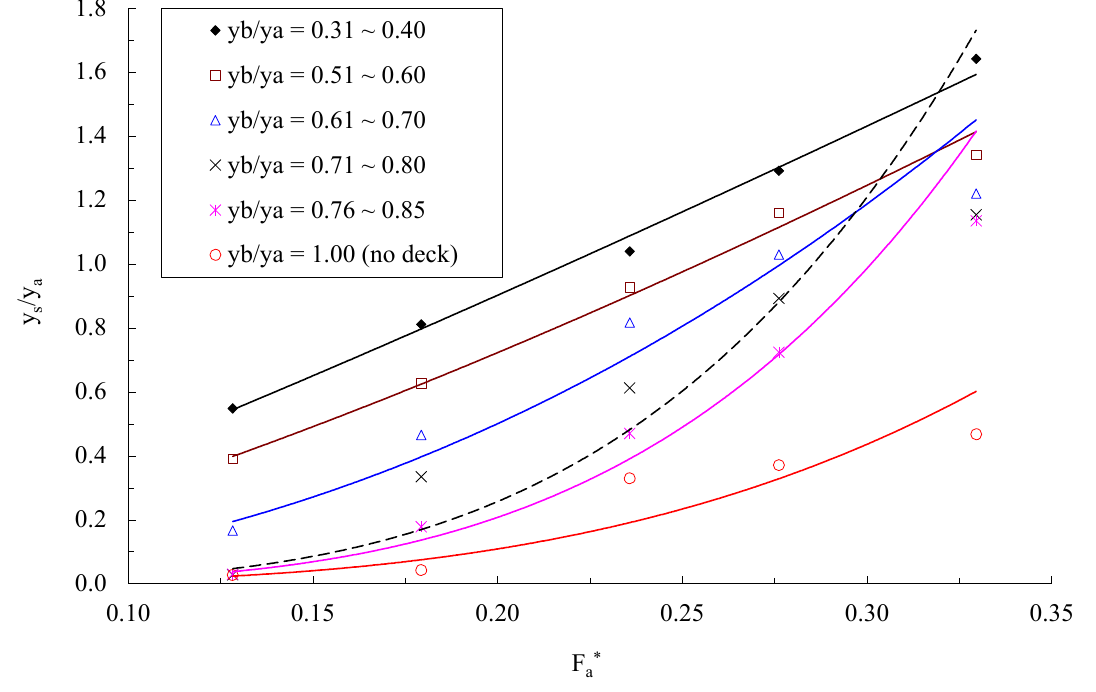
Figure 4. Relative maximum scour depth (y s /y a ) versus the densimetric Froude number ( F ∗ a ) for different relative bridge openings (y b /y a ).